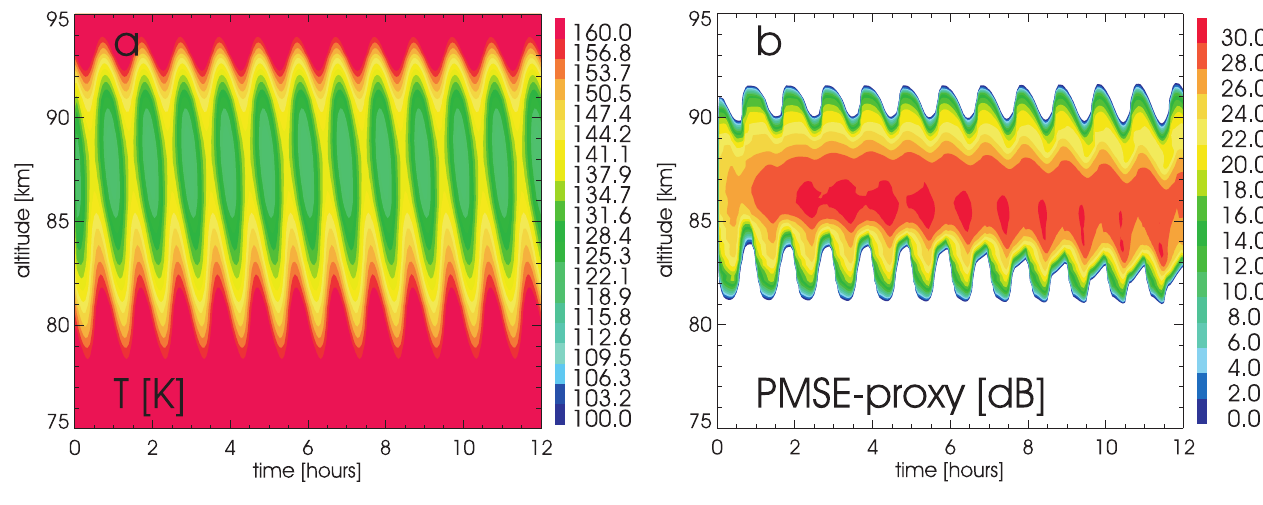
Fig. 8. Simulation of the influence of a short period gravity wave on PMSE: (a) temperature variations caused by a gravity wave with a period of 1h, (b) resulting PMSE